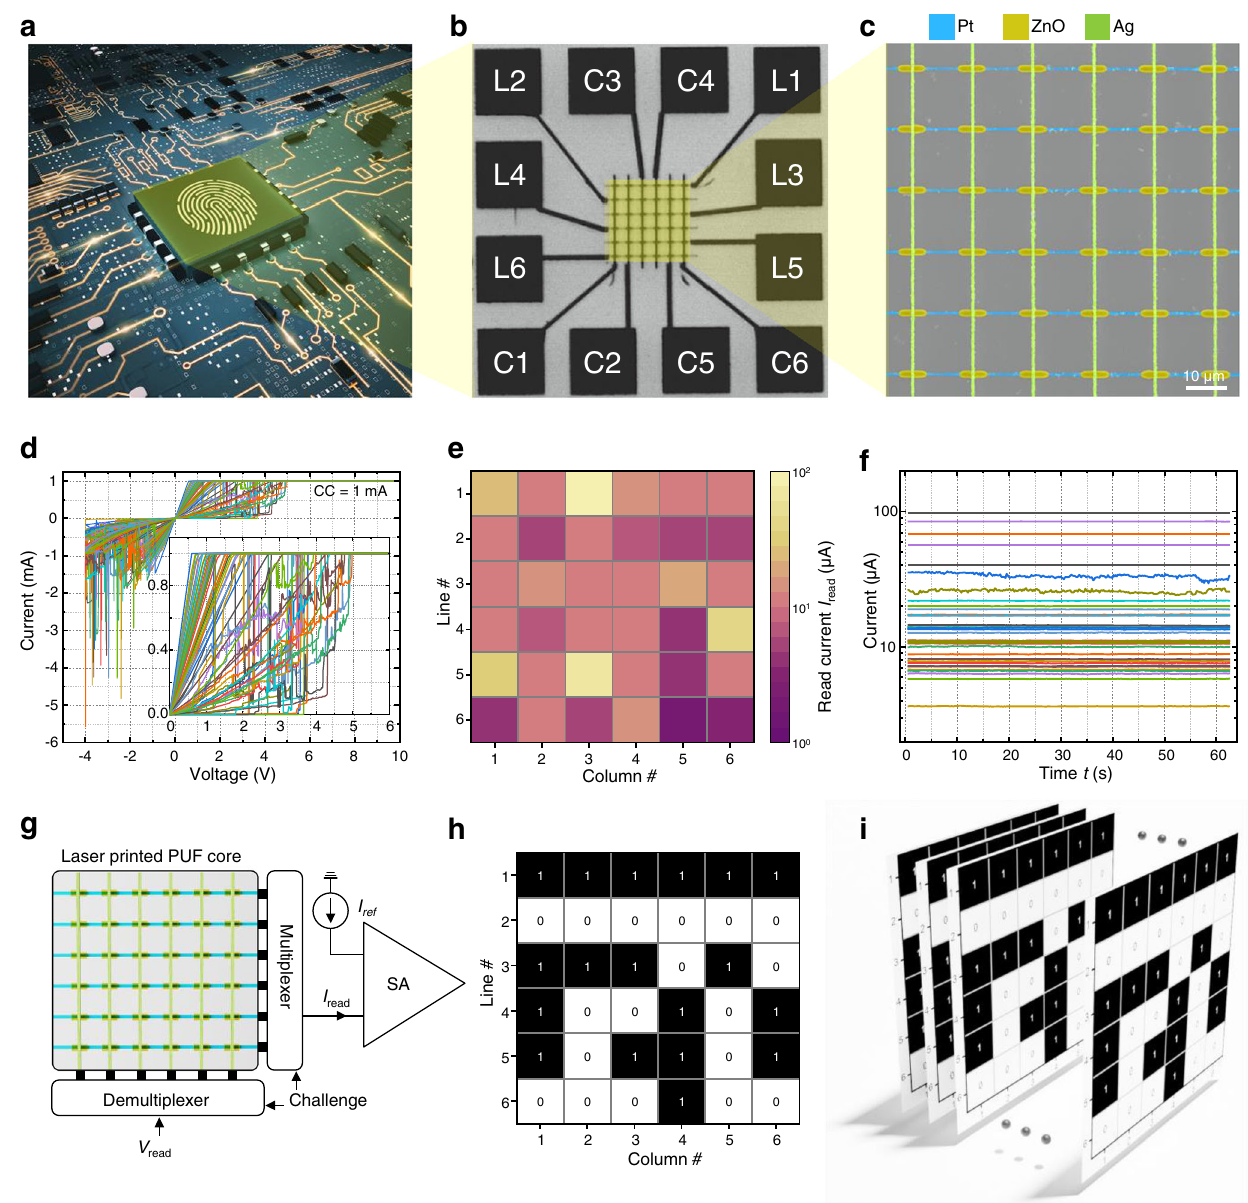
Fig. 5 | Laser-printed Pt-ZnO-Ag security circuits. a Schematic of an embedded hardware-based security primitive, based on a physically unclonable function (PUF). b Optical micrograph of a laser-printed 6×6 crossbar array with contact pads. c Scanning-electron micrograph of a laser-printed 6×6 crossbar array, showing a period of 1.5 µ m in both, horizontal and vertical directions. The mem- ristive devices are located at the wire crossing junctions. d Activation of the 36 memristor cells by sweeping a voltage from 0V ! 10V ! (cid:2) 4V ! 0V. The inset